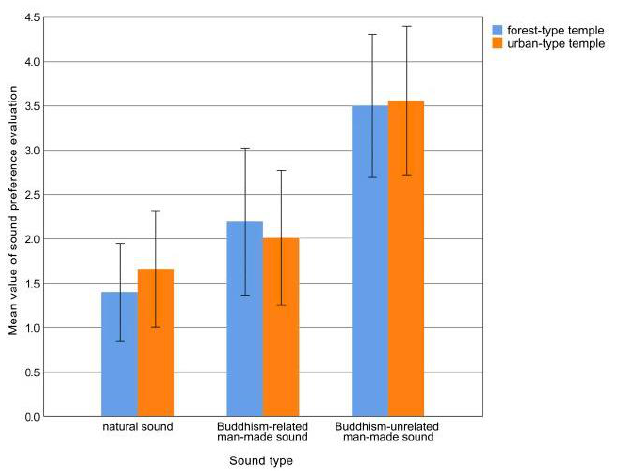
Figure 9. The evaluation value and standard deviation of preference for different sounds in the temple.